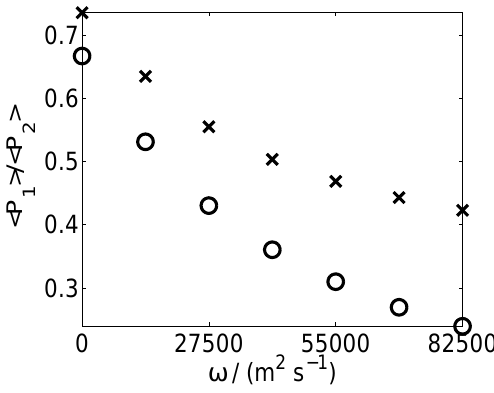
Fig. 17. Ratio of the spatio-temporal average abundance of the two phytoplankton groups versus the eddy diffusivity.